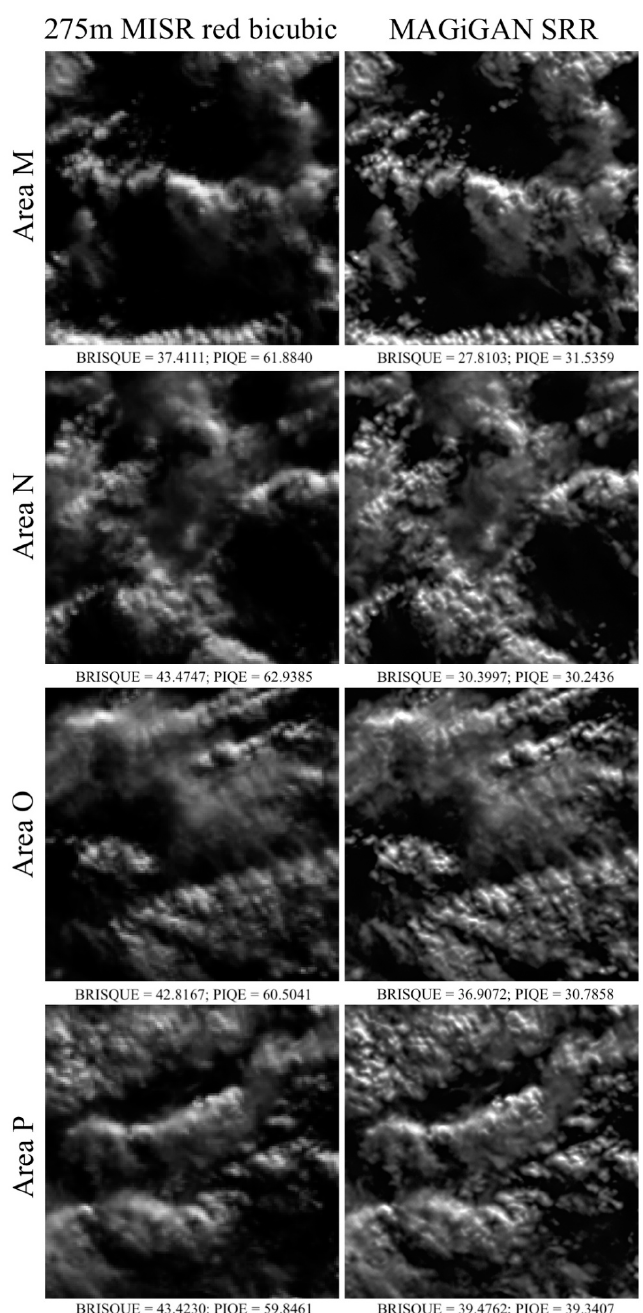
Figure 6. MISR red band SRR results at clouds field in comparison with the original 275 m MISR red band image (bicubic interpolated to the same scale as SRR image). BRISQUE and PIQE scores are provided below each image.